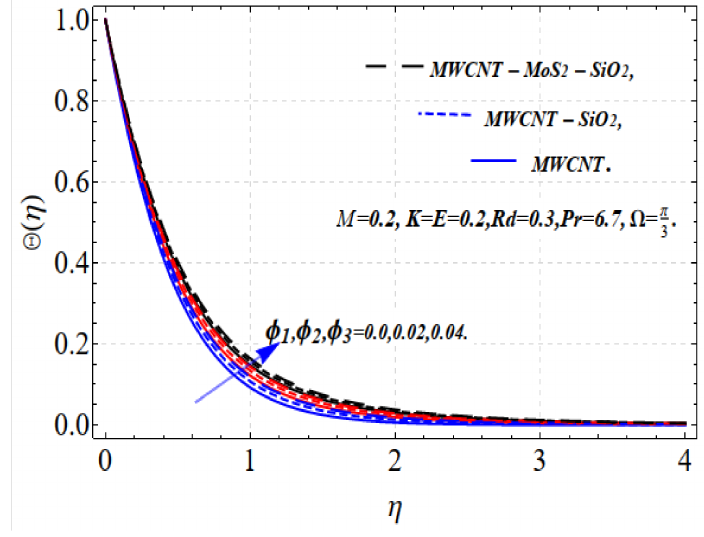
Figure 4. Θ ( η ) vs. φ 1 , φ 2 , φ 3 .